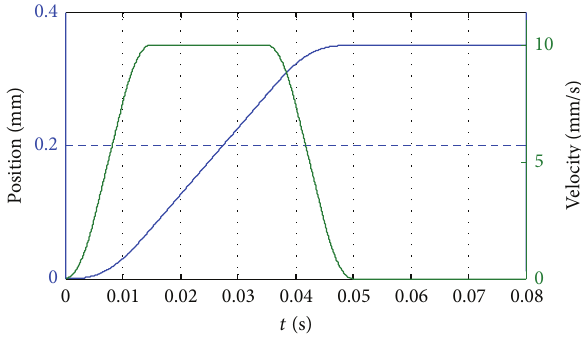
Figure 10: Reference position and velocity.